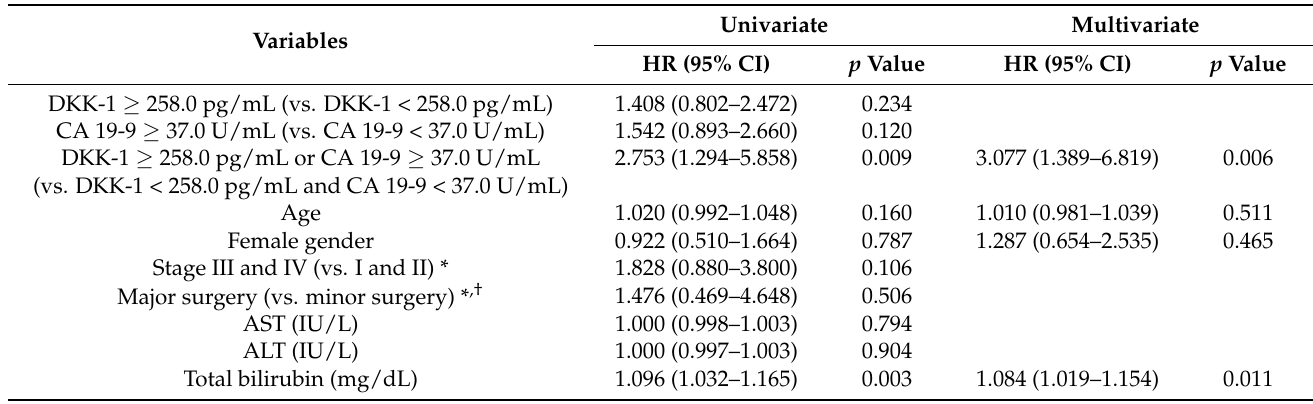
Table 2. Univariate and multivariate analysis to identify independent predictors for survival in patients with ICC. Univariate Variables